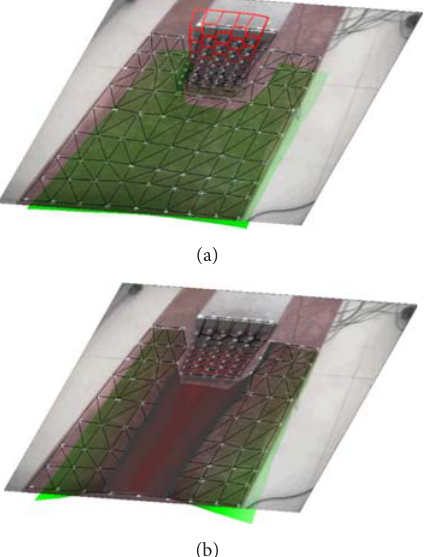
Figure 19: Two-node vertical mode shape of the control base: (a) mode shape of the auxetic cellular base and (b) mode shape of the steel grillage.